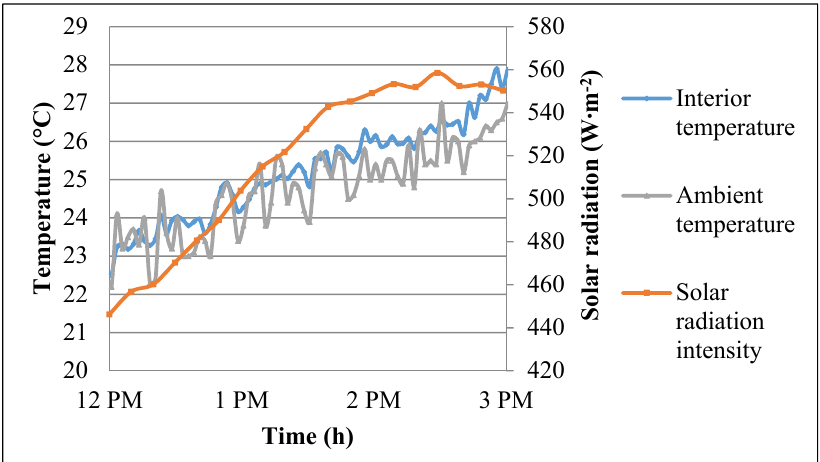
Figure 13. The relations for solar radiation intensity, ambient temperature, and interior temperature during the evaluated time period.